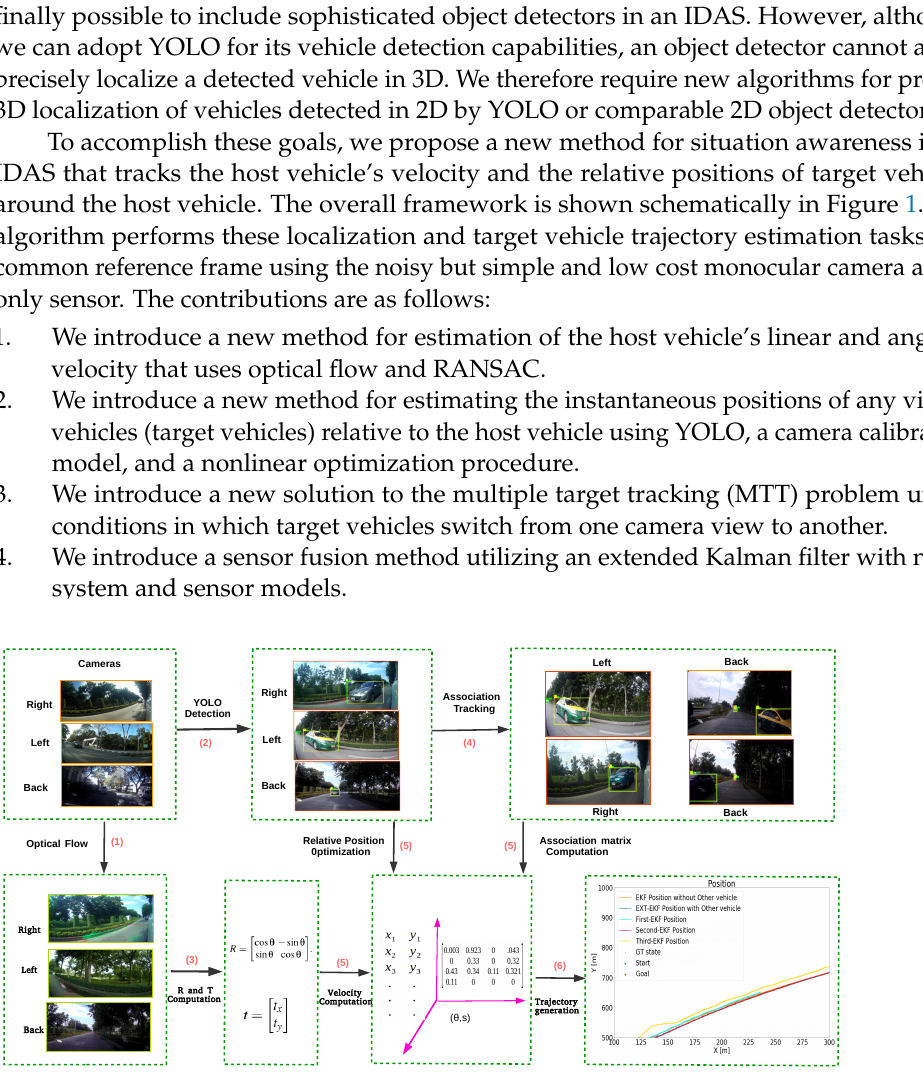
Figure 1. Framework of proposed model. Our experiments use three cameras, one oriented back- wards and two oriented approximately 45 ◦ outward from the side-view mirrors. The framework estimates the linear velocity and angular velocity of the host vehicle using optical flow (1) followed by RANSAC (3). In parallel, it predicts the relative positions between the host vehicle and any visible target vehicles (2). The method also solves the problem of MTT under conditions in which target vehicles switch from one camera view to another (4). The last step of the method performs sensor fusion using an extended Kalman filter utilizing novel system and sensor models (5). The resulting trajectories are fused into a common world coordinate system (6), then visualized for situation awareness. Note: the data in part (6) are from Experiment